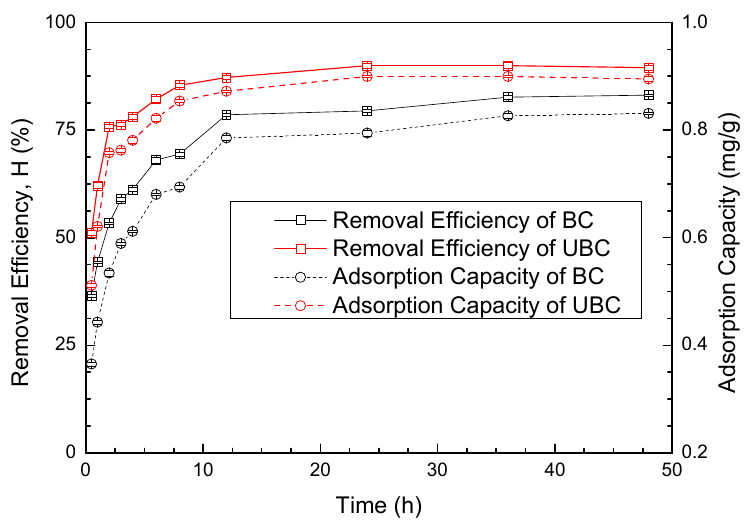
Figure 2. Comparison of RB5 removal efficiency and adsorption capacity between BC and UBC.